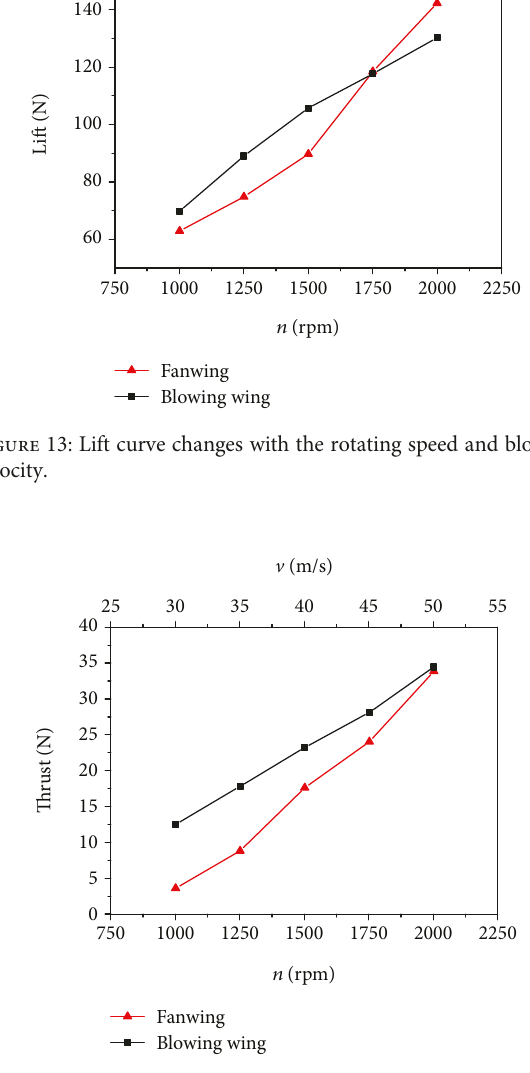
Figure 14: Thrust curve changes with the rotating speed and blowing velocity.